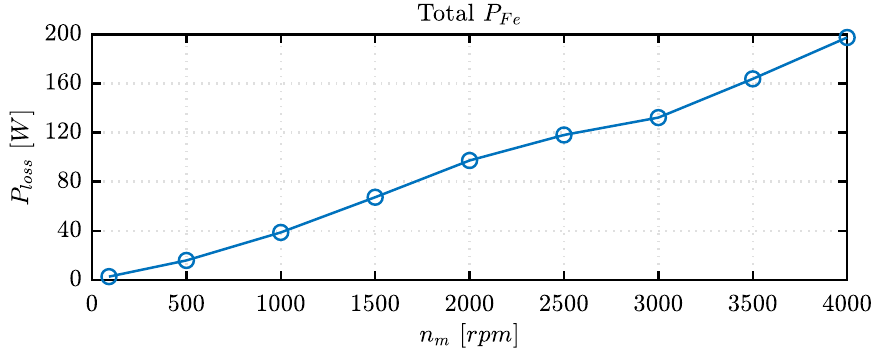
Figure 21. Iron loss at different speeds.